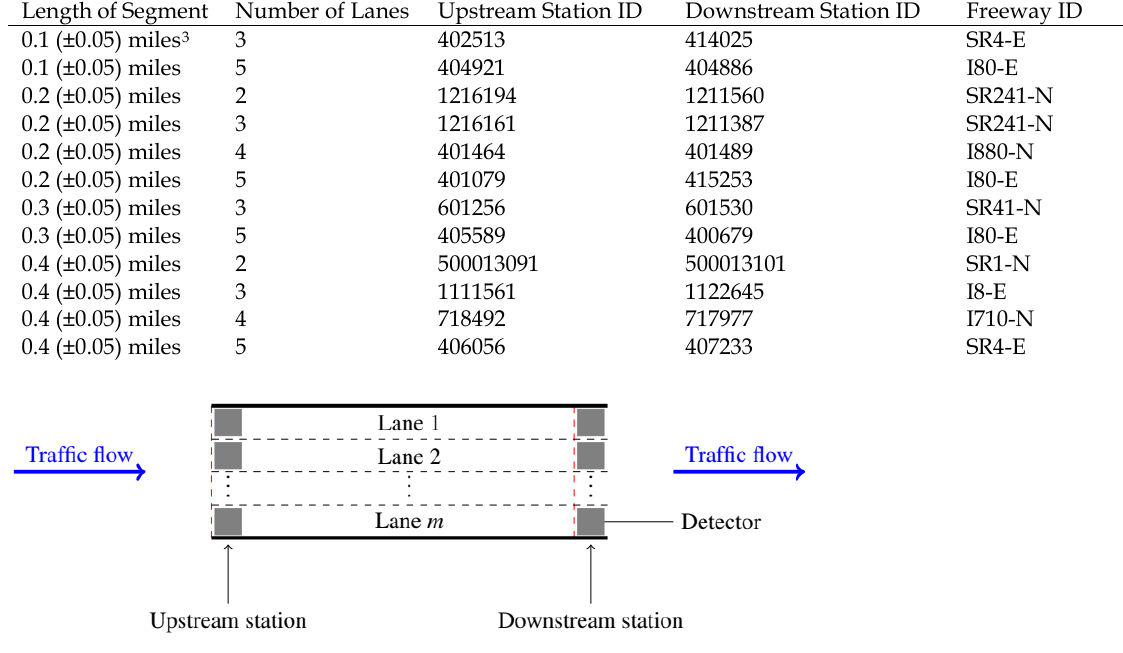
Figure 2. A segment and its attached